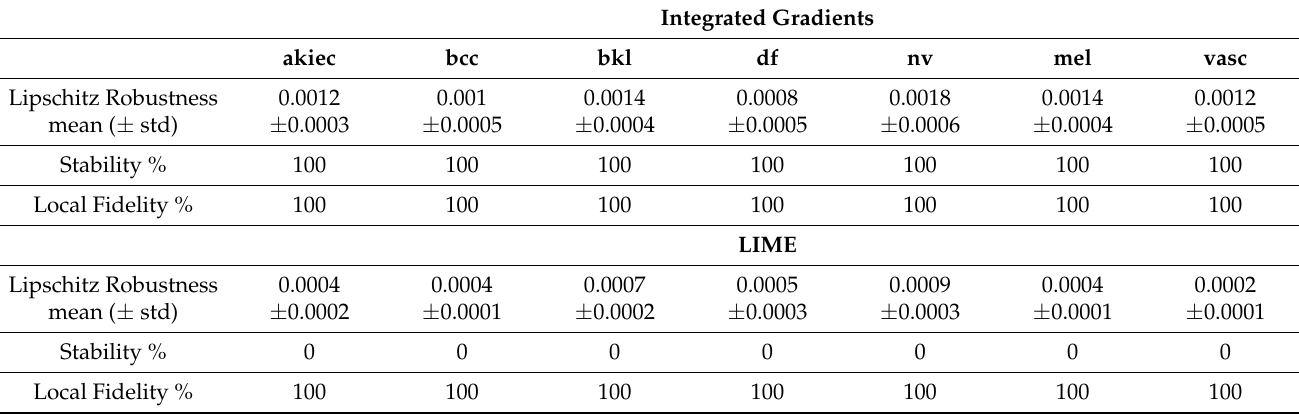
Table 2. Quantitative quality indicators for the different explanation techniques.